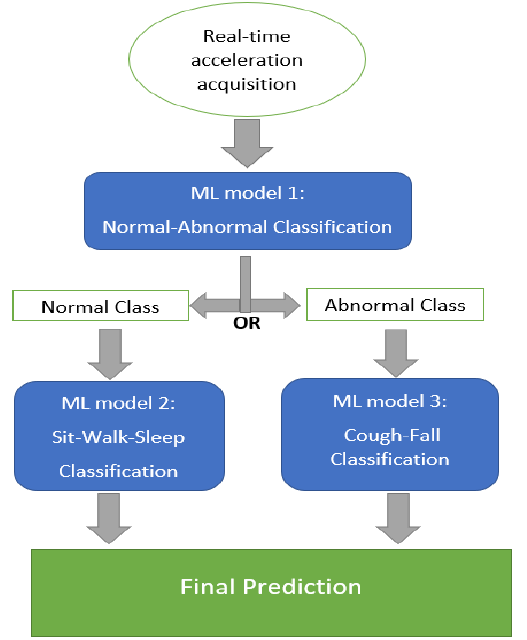
Figure 6. Logical execution chart of the PTLE system.